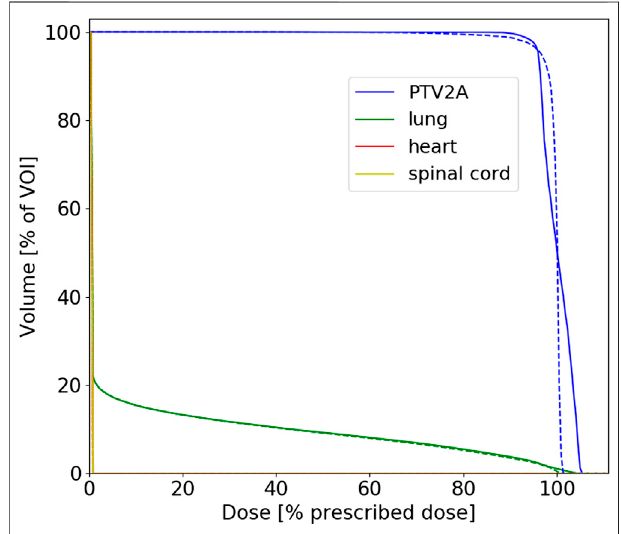
FIGURE 10 | DVHs for proton plans calculated on patient case P2 for non-modi fi ed (solid lines) vs. sum of 100 modi fi ed CTs (dashed lines). The corresponding planning parameters and dosimetric indexes are given in the